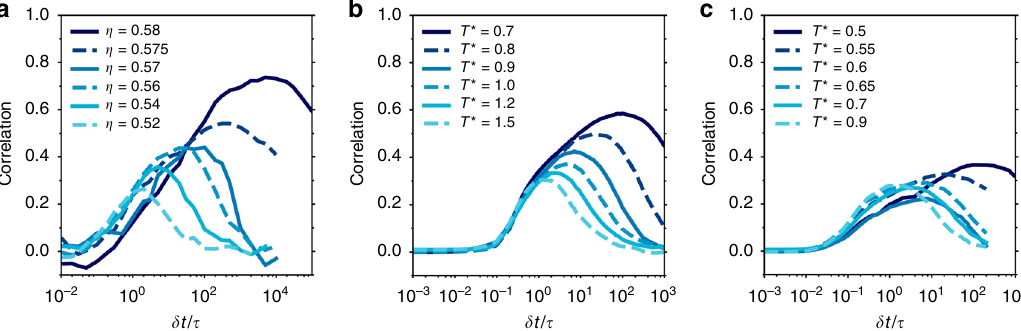
Fig. 5 Correlation between structure and dynamics for different supercoolings. Correlation between the locally averaged (cid:1) P red and dynamic propensity for large particles (see Supplementary Note 3 and Supplementary Fig. 8 for small particles). Note that the averaging radius for (cid:1) P red is 2 σ A in all cases. In all cases, the UML approach is retrained on a snapshot from the system in question. The systems are a hard spheres, b Wahnström, and c Kob – Andersen.